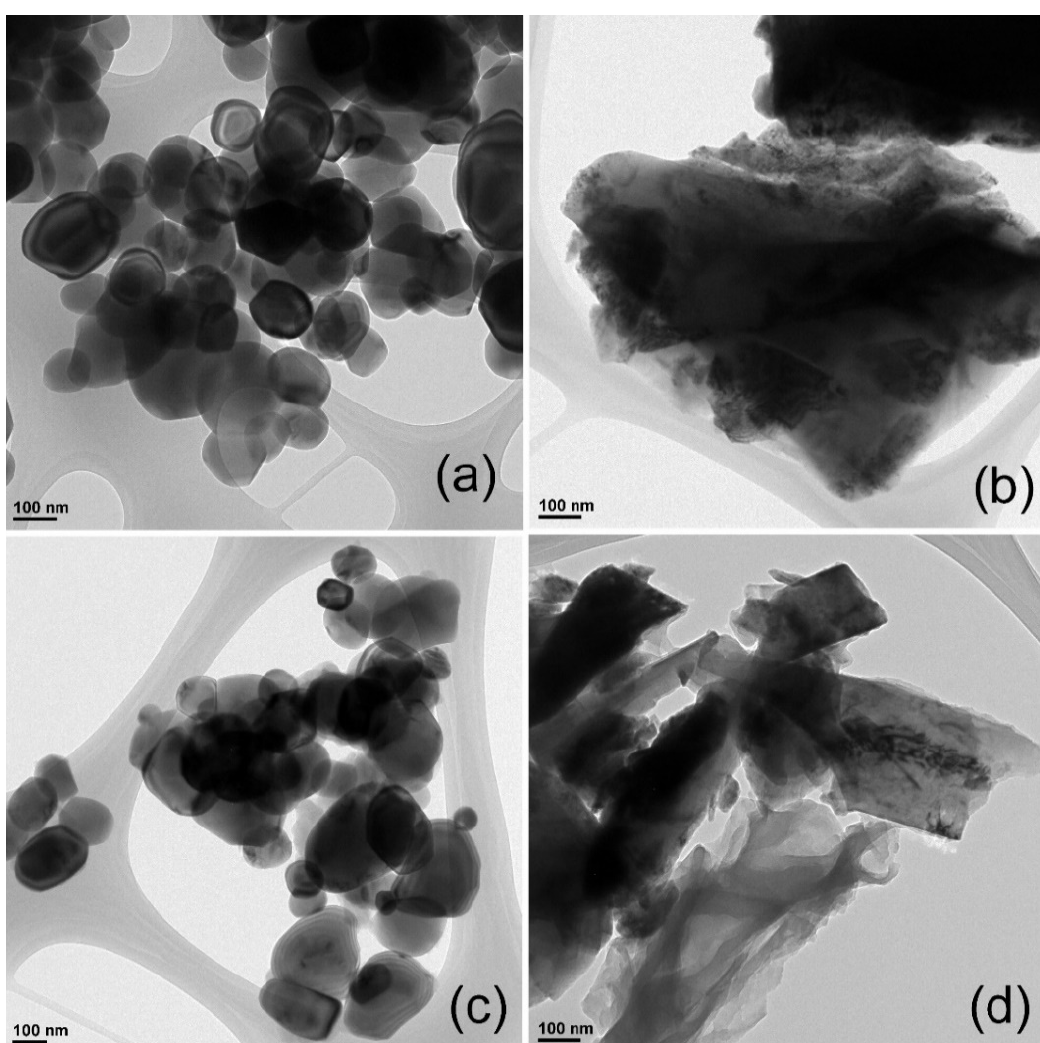
Figure 5. Transmission electron microscopy (TEM) images of: ( a ) TiC; ( b ) PANI@TiC; ( c ) TiO 2 –TiC; and ( d ) PANI@TiO 2 –TiC.